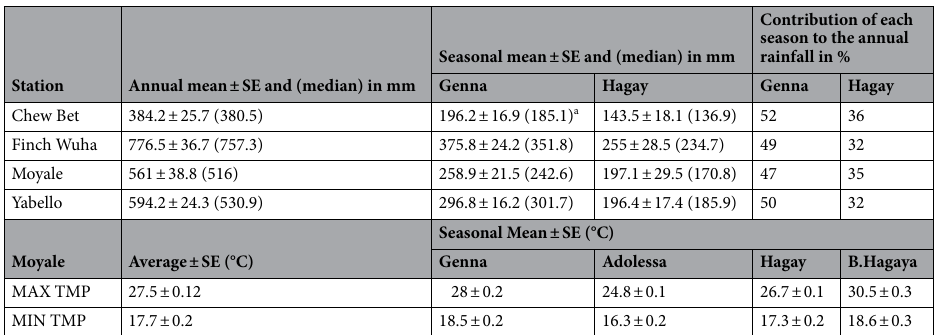
Table 1. Summary statistics of temperature, precipitation and contribution of each season to annual rainfall (1990–2017). Source (Author): Computed based on data from the NMA of Ethiopia. Long rainy season, “Genna” (Mar–May); short rainy season, “Hagaya” (Sep–Nov); cold dry season, “Adolessa” (June–Aug) and long dry season, “Bonna Hagaya” (Dec–Feb). a Median.